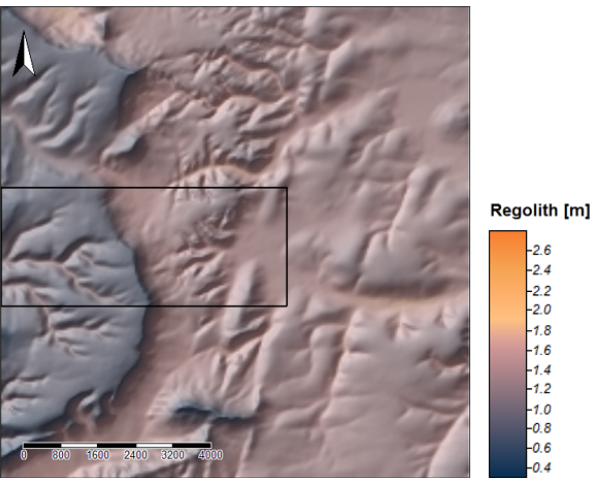
Figure 8. First results of the SaLEM simulation in Ebergötzen showing distributed regolith thicknesses resulting from 50ka mod- eling with initial 50cm regolith cover. The rectangle indicates the area where a first validation of the results was conducted.